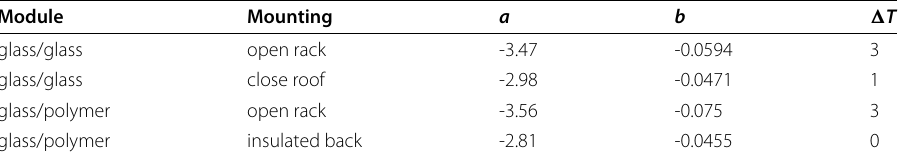
Table 2 Typical temperature model parameter sets for different panel types and installations (King et al. 2004) Module Mounting a b (cid:2) T glass/glass open rack -3.47 -0.0594 3 glass/glass close roof -2.98 -0.0471 1 glass/polymer open rack -3.56 -0.075 3 glass/polymer insulated back -2.81 -0.0455